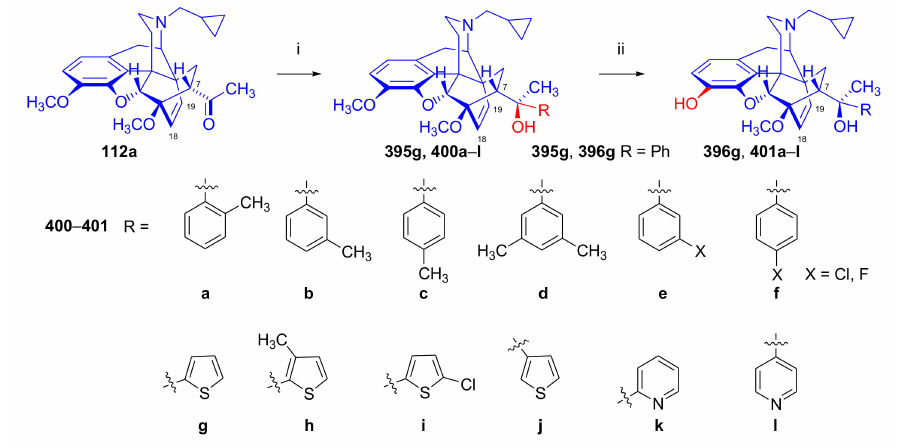
Figure 102. Synthesis of 20-aryl-thevinols and orvinols. Reagents and conditions : (i): for preparation of 20 S -aryl-thevinols: arylmagnesium halides, toluene, room temperature, 22 h; for preparation of 20 R -piridyl-thevinols: (1) pyridyl halide, n -BuLi, Et 2 O, − 78 ◦ C, under nitrogen, 10 min, (2)